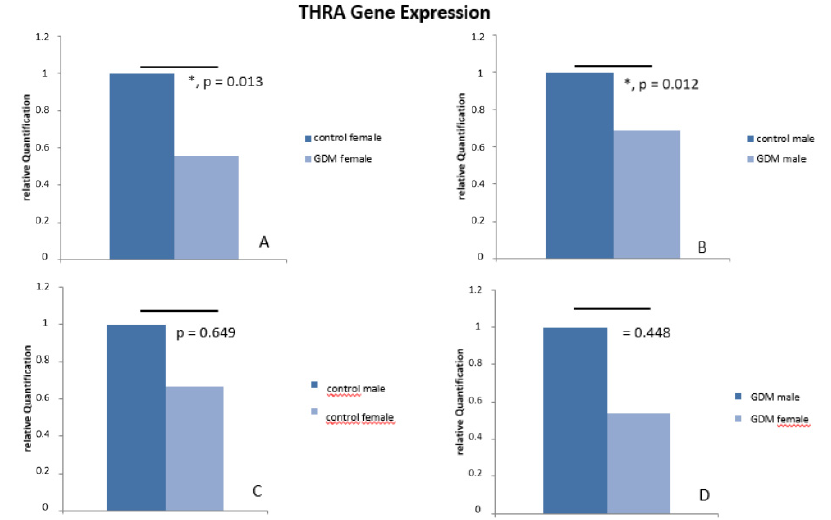
Figure 7. Results of THRA gene expression analysis with TaqMan RT-PCR. We identified a significant reduction of THRA in GDM, in both female and male GDM placentas in comparison to controls. ( A , B ). There was no significant difference between THRA mRNA levels between male and female placenta, neither in control ( C ) nor in GDM ( D ).